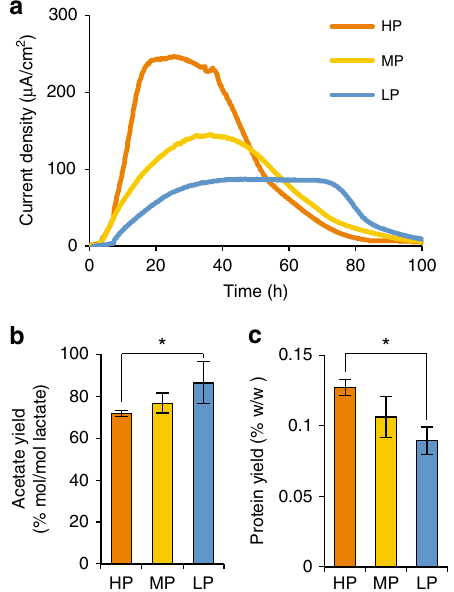
Fig. 1 Response of S. oneidensis MR-1 to different electrode potentials. a Current generation from lactate in electrochemical cells (EC) operated with high potential (HP; + 0.5 V), middle potential (MP; + 0.2 V), or low potential (LP; 0 V) electrodes. Results represent the mean of three independent experiments ( n = 3 biological replicates). b , c Acetate ( b ) and protein ( c ) yields from lactate under HP and LP conditions. Bars and error bars represent means and standard deviations (s.d.), respectively ( n = 3 biological replicates). Asterisks indicate a statistically signi fi cant difference ( P < 0.05; one-way ANOVA followed by LSD